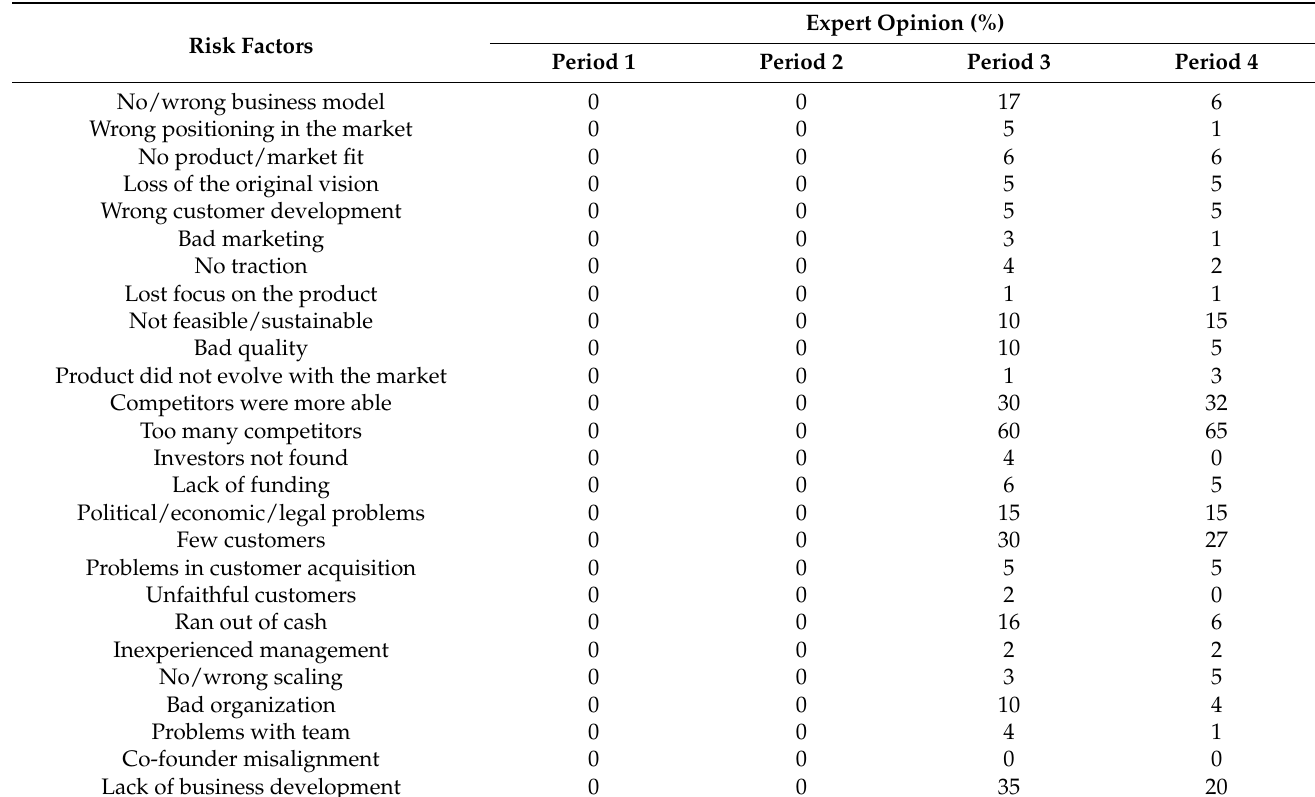
Table A2. The expert’s opinion about start-up X.